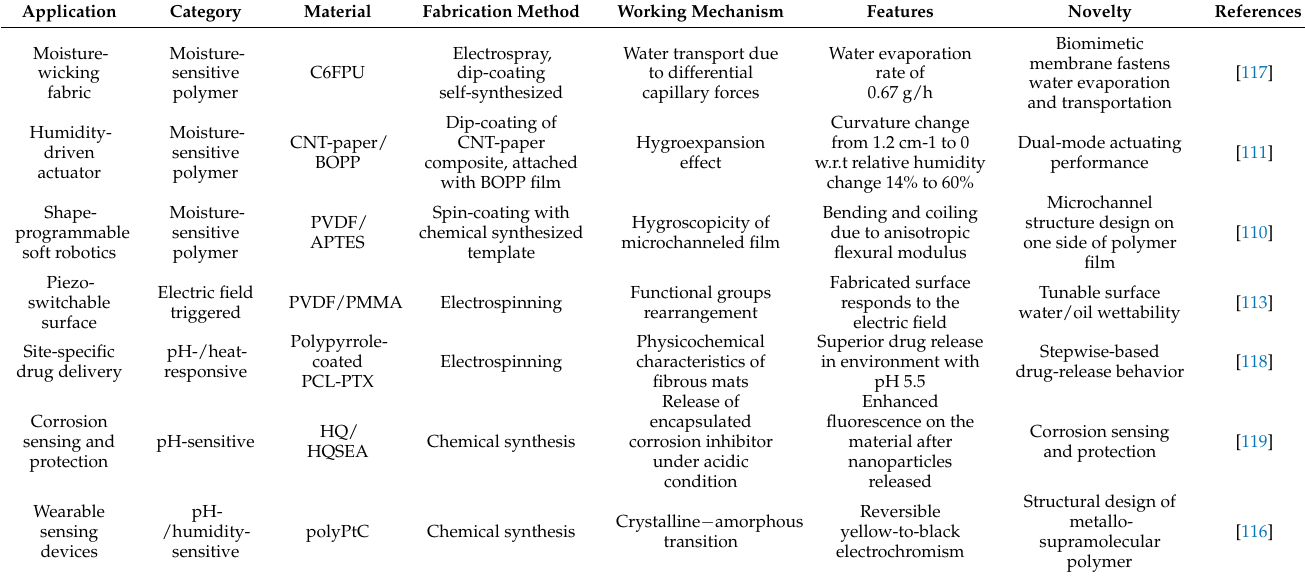
Table 3. Selected comparison of multiple stimuli-driven polymer